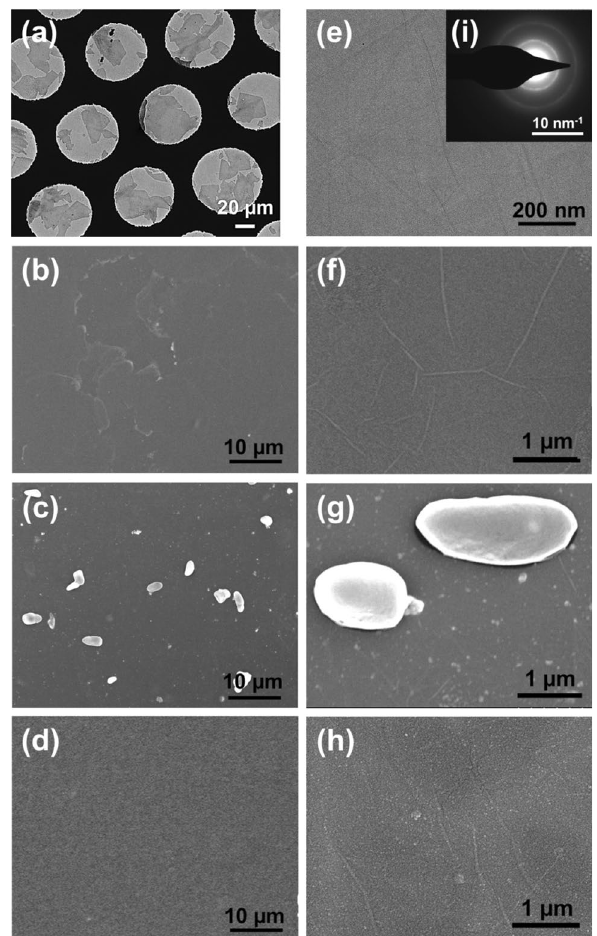
Figure 2. ( a , e ) TEM images and ( i ) required diffraction pattern of GO. SEM images of pure GO films ( b , f ) without reduction; ( c , g ) reduced twice by SnCl 2 for 10 min; ( d , h ) reduced twice by SnCl 2 for 10 min and treated by